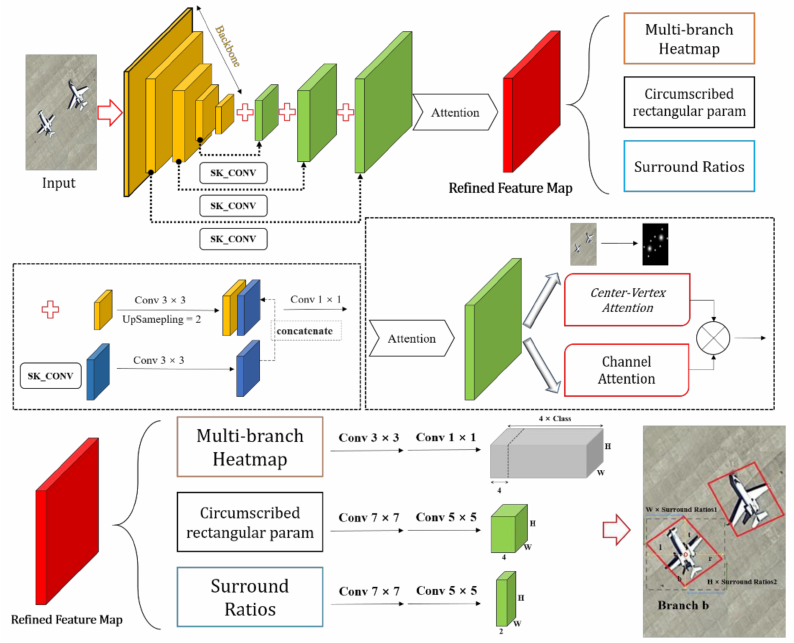
Figure 3. The overall architecture and the oriented bounding box descriptions of the proposed method.